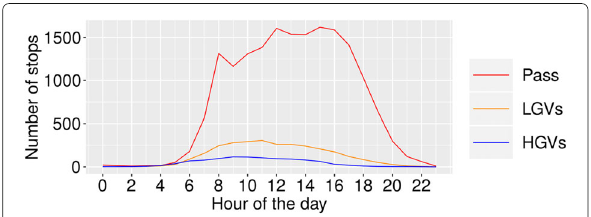
Fig. 18 Average number of stops in the region per hour